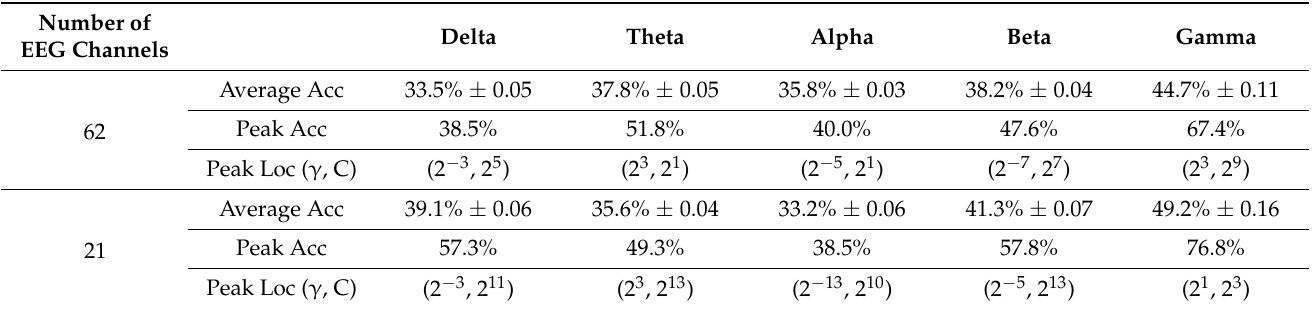
Table 2. Accuracies of the SVM-ML model for classifying the three upper-limb groups with the RBF kernel hyperparameter pairs in different frequency bands.